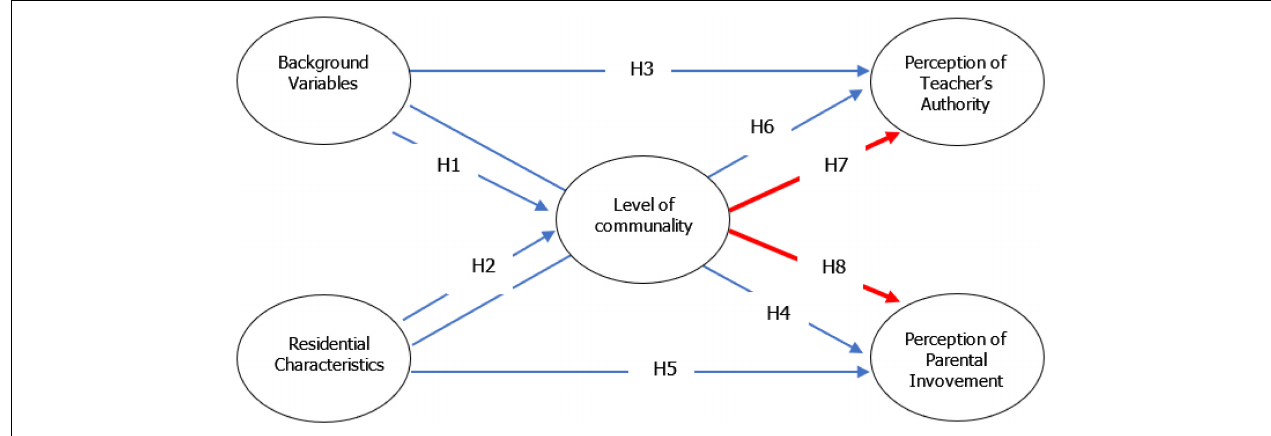
FIGURE 1 | Conceptual